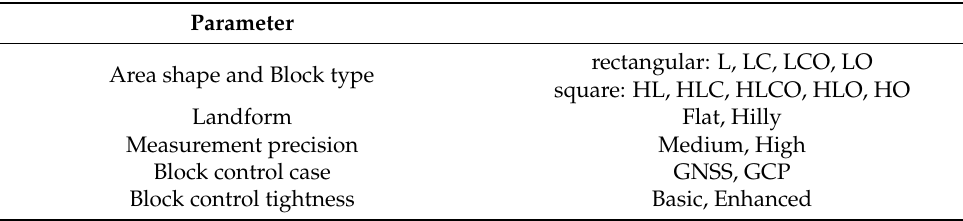
Table 5. Parameters accounted for in the simulated